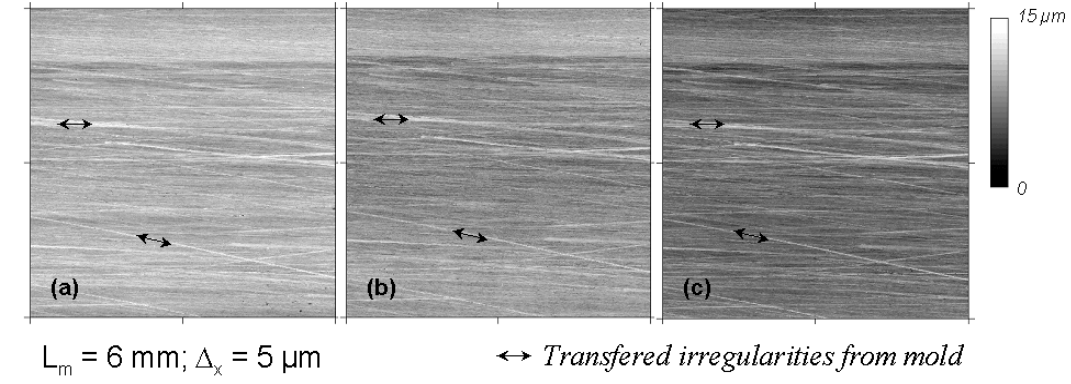
Figure 10. Transference of mould grooves defines the meso-topography of third level (DIN 4760) of SMC surfaces. Moulding conditions: (a) 5 MPa and 160s). (b) 5 MPa and 360s. (c) 10 MPa and